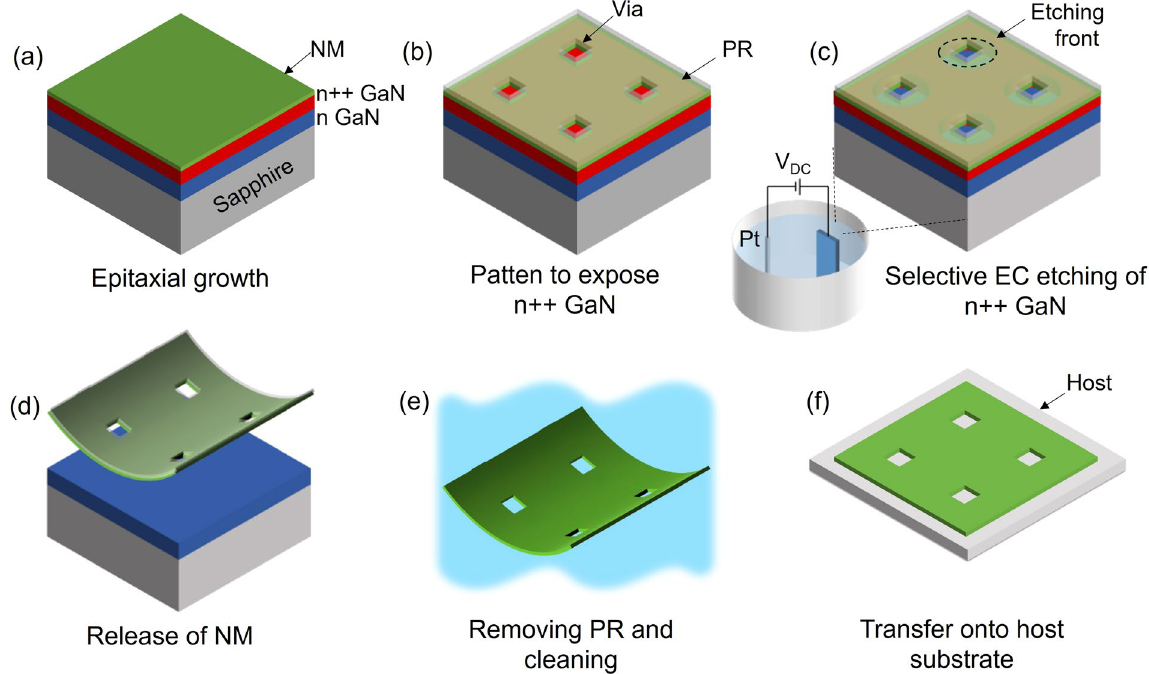
Figure 1. Fabrication procedure of III-Nitride NM. ( a ) Epitaxial growth of NM to be lift-off with an underneath n ++ GaN layer, ( b ) photolithograph and dry etching to expose n ++ GaN sidewalls with arrays of vias, ( c ) selective undercut etching of n ++ GaN by electrochemical etching, ( d ) separation of NM from epitaxial wafer after full undercut, ( e ) removal of photoresist and cleaning the NM, ( f ) transfer the freestanding NM onto a host